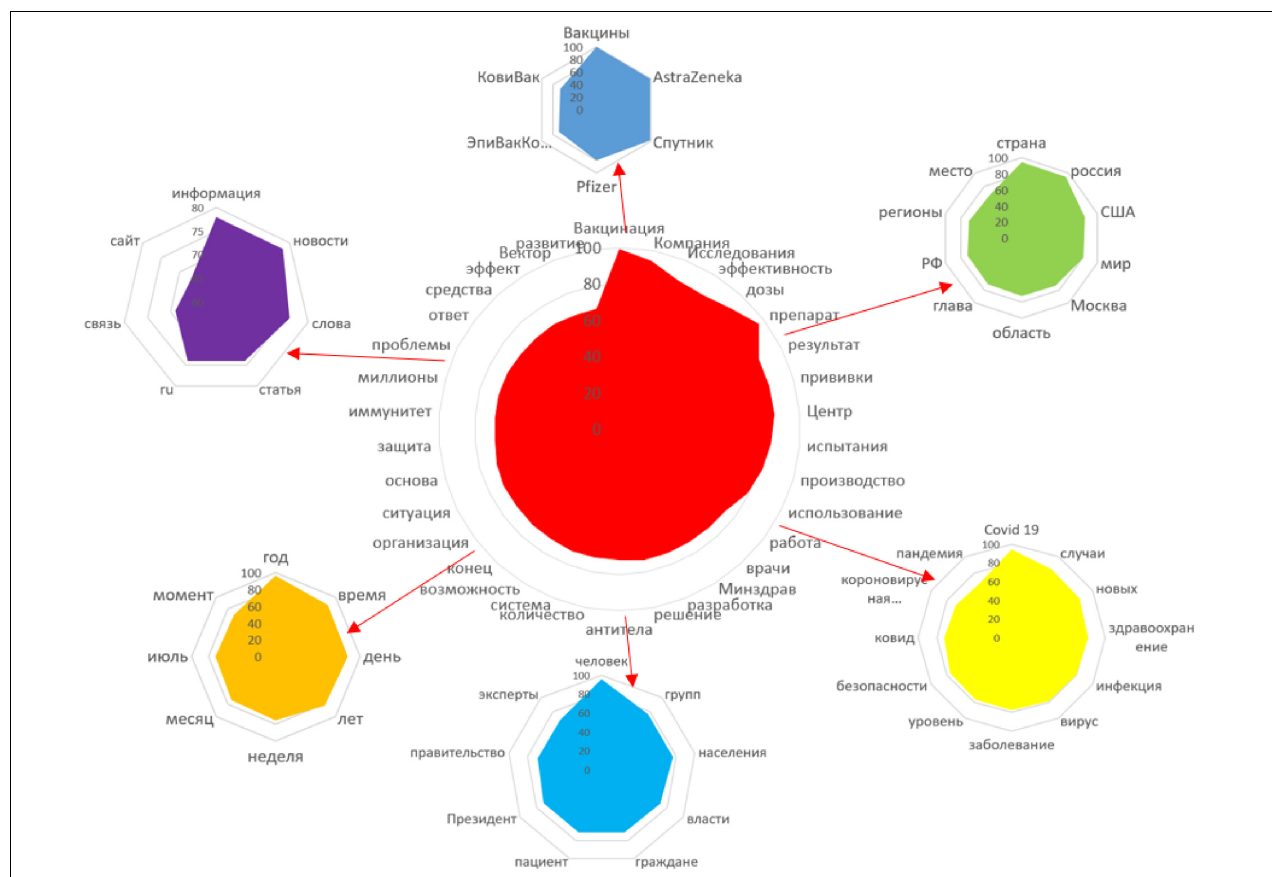
FIGURE 7 | Features of vaccine production and specificity of